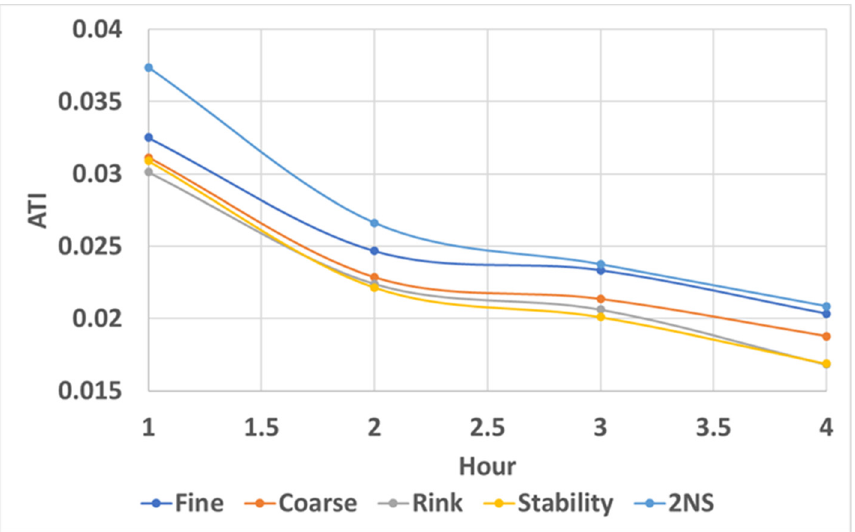
Figure 5. Plot of the average change in ATI over time for each of the five soils.